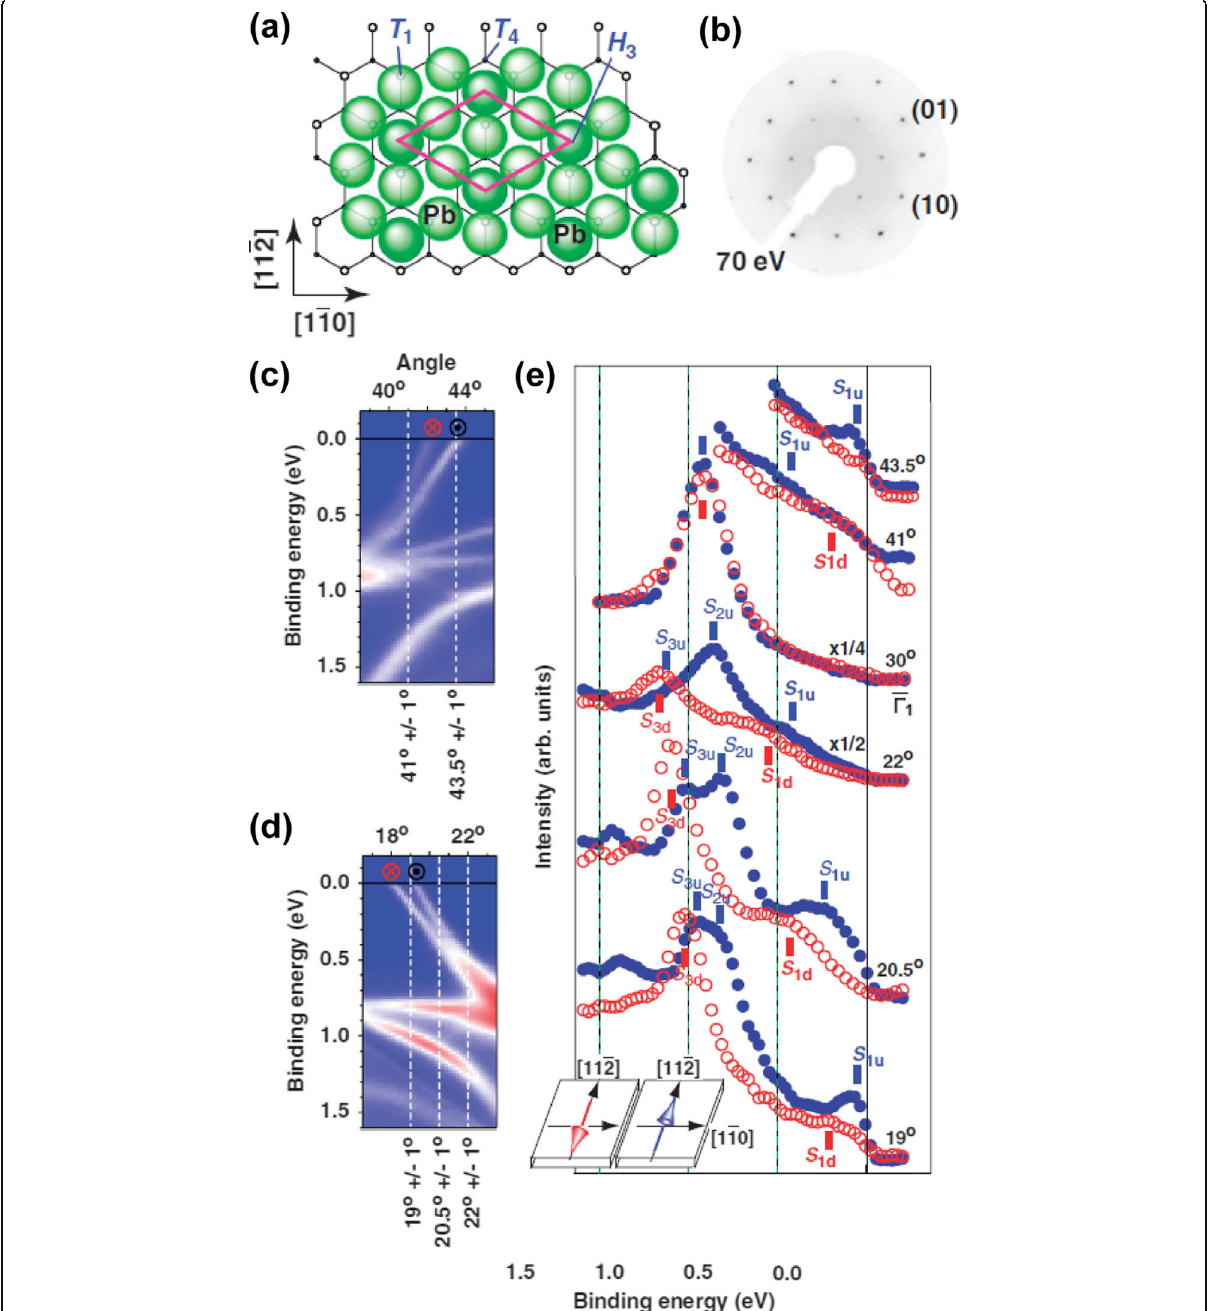
Fig. 3 Crystalline and electronic structures of Ge(111)- β ( √ 3 × √ 3)-Pb. a Atomic structure model. b Low energy electron diffraction (LEED) pattern. c , d Spin-unpolarized ARPES spectra. e Spin-resolved ARPES spectra measured at several selected angles. Reprinted by permission from Macmillan Publishers Ltd.: K. Yaji, et al. Nat. Commun. 1 , 17 (2010) [28], copyright 2010.